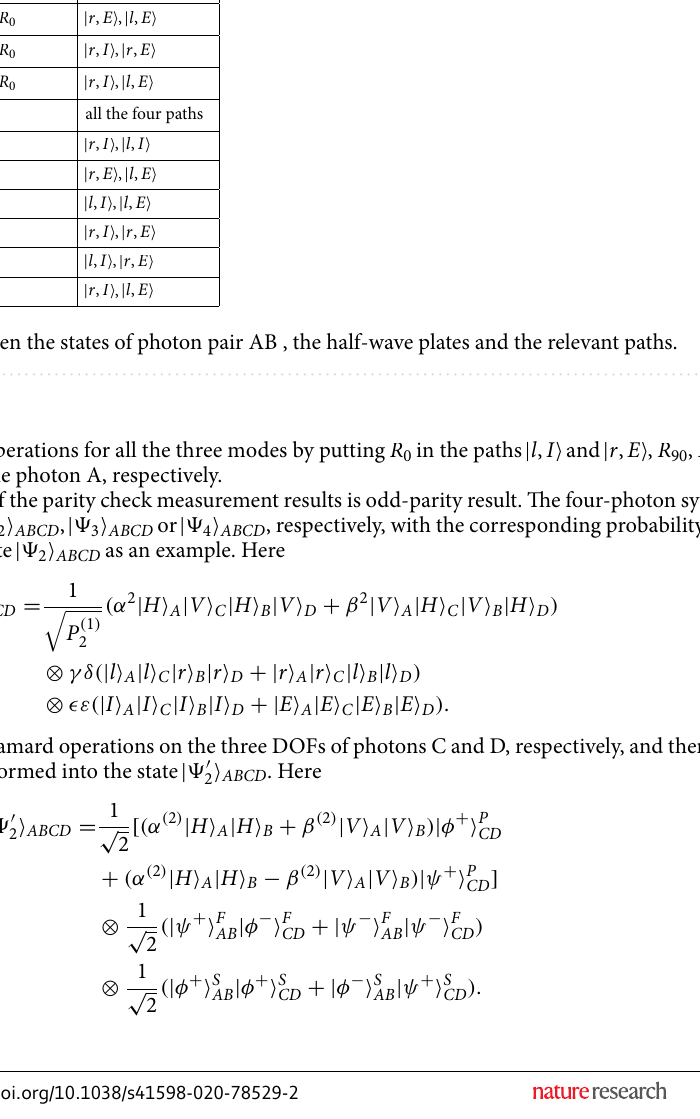
(cid:31) ′ 2 . Here | � ABCD